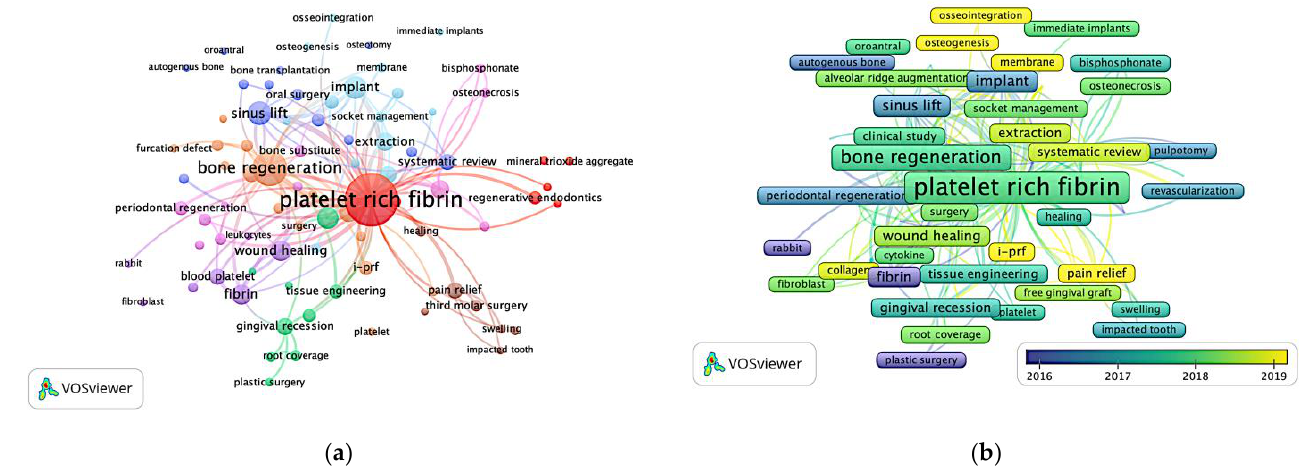
Figure 7. Bibliometric analysis of author keyword: ( a ) Eight trend topics of PRF studies, which were bone regeneration in orange, wound healing in purple, periodontology in green, molar surgery and pain relief in brown, regenerative endodontics in red, as well as implant and osseointegration in light blue; ( b ) Yearly distribution of overlay author keyword visualization after normalization. It showed that more research pertained on PRF derivates, a-PRF and i-PRF, as well as pain relief, osseointegration, and systematic review, have been published